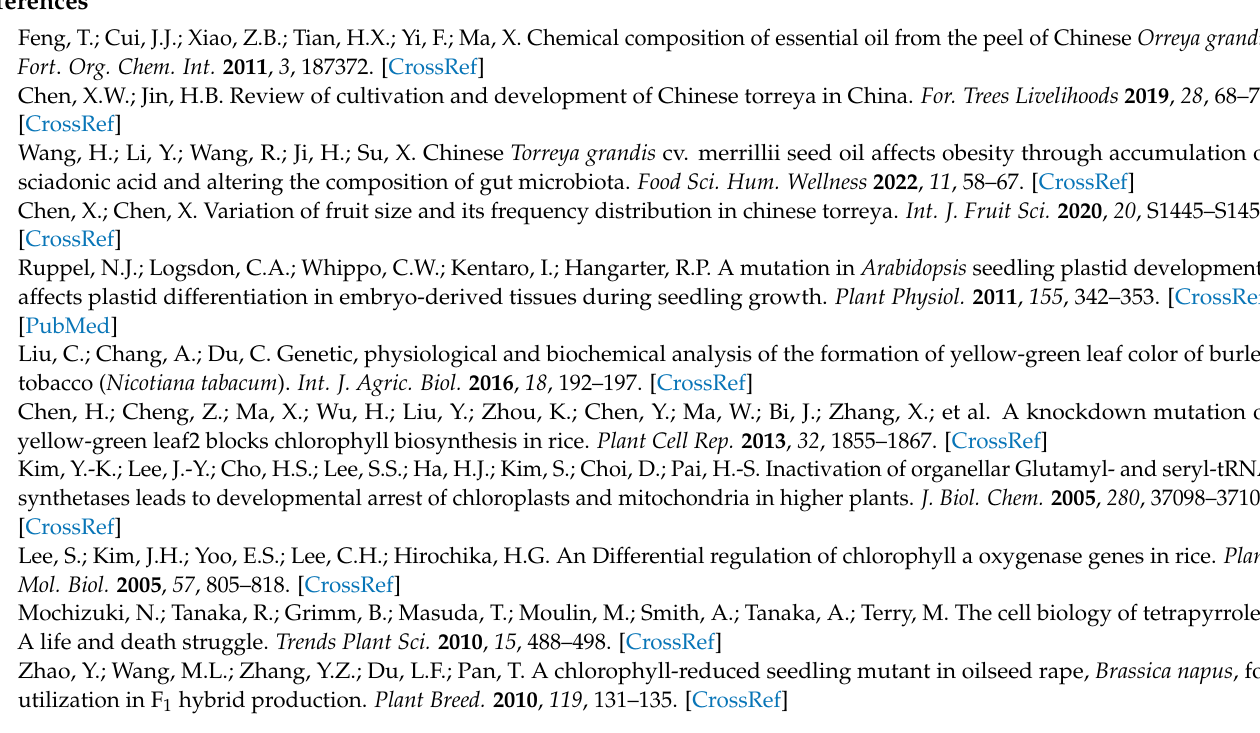
Table S3: Number of total clean reads of the six samples mapped to reference sequences. Table S4: Success rate statistics of transcript annotation using seven databases. Table S5: The expression values of transcript data in six